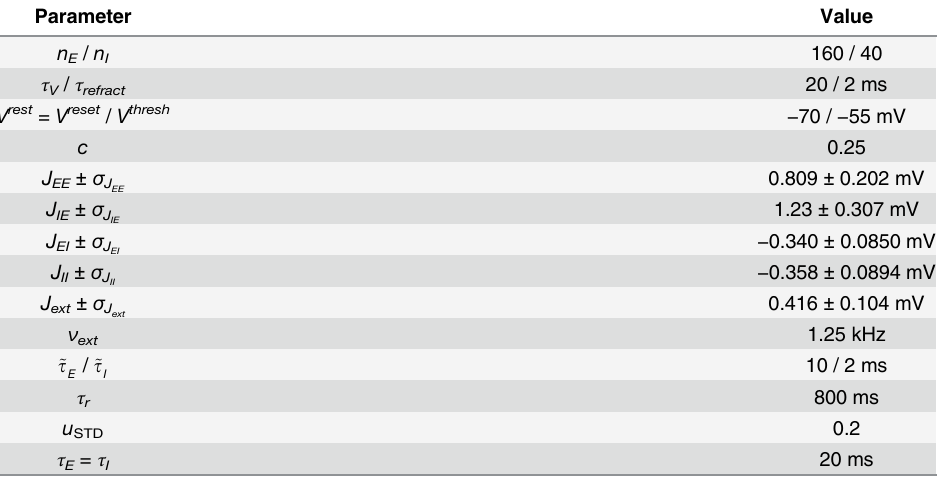
Table 1. Network